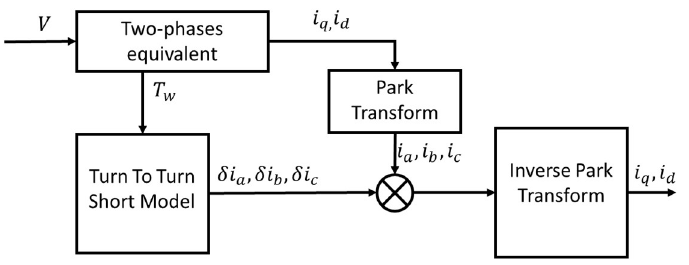
Figure 11. Implementation of the turn-to-turn short in the real-time model.